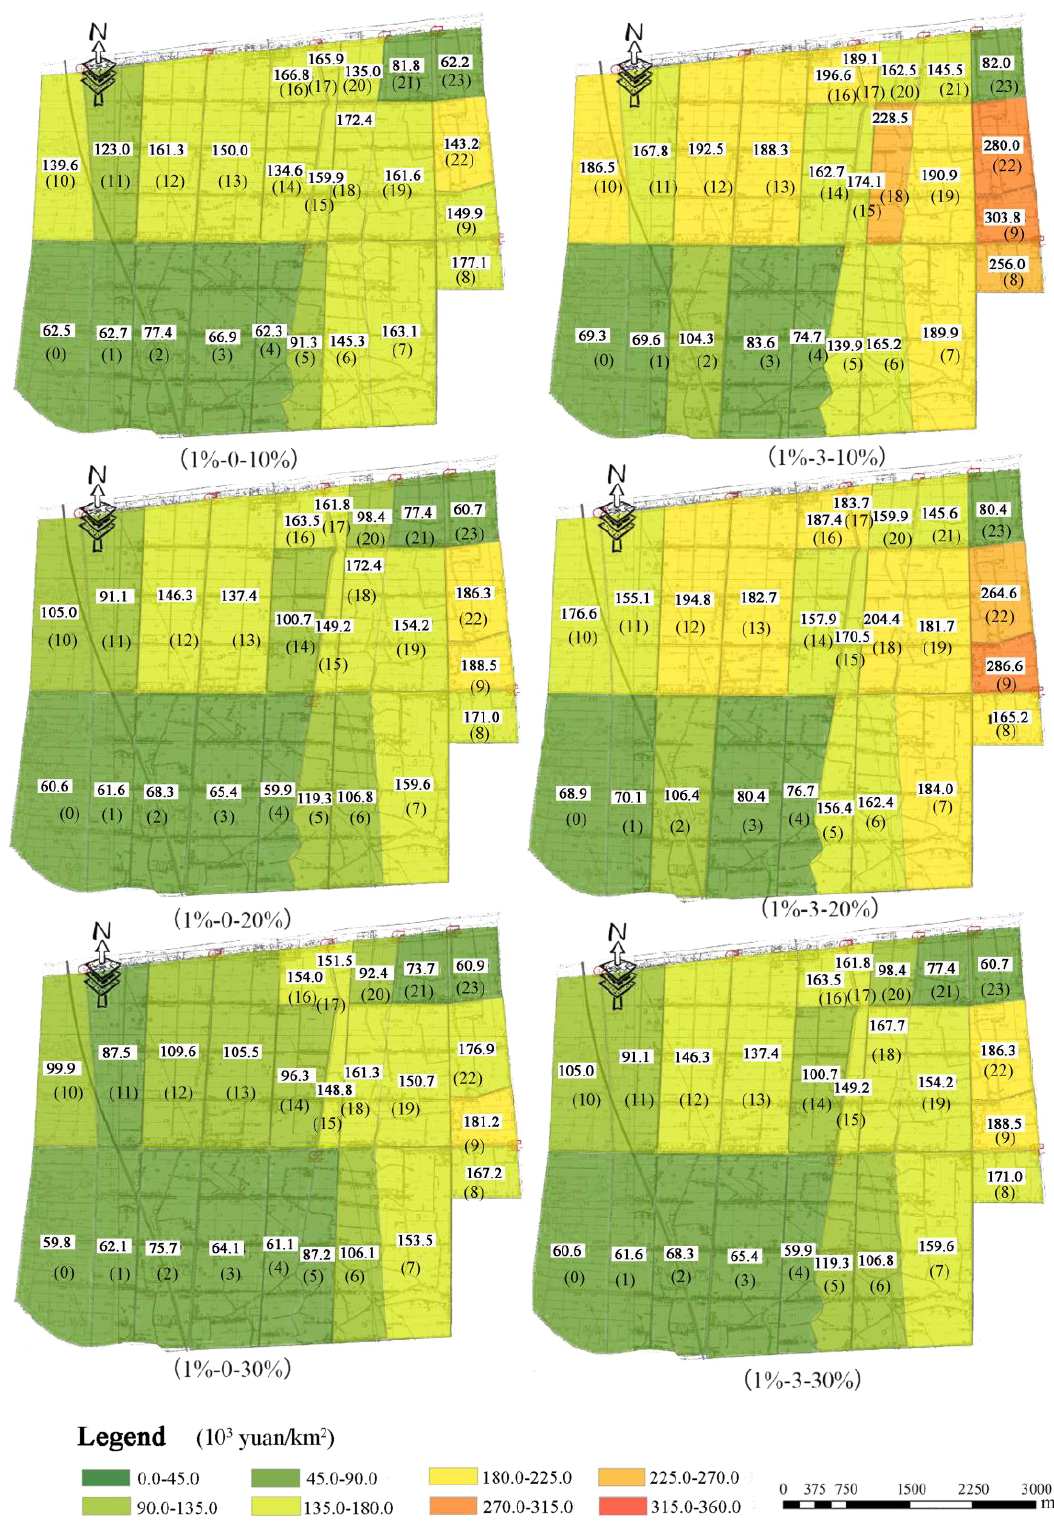
Figure 14. Distribution of averaged waterlogging loss with different initial storage depths and work scales under 1% frequency.